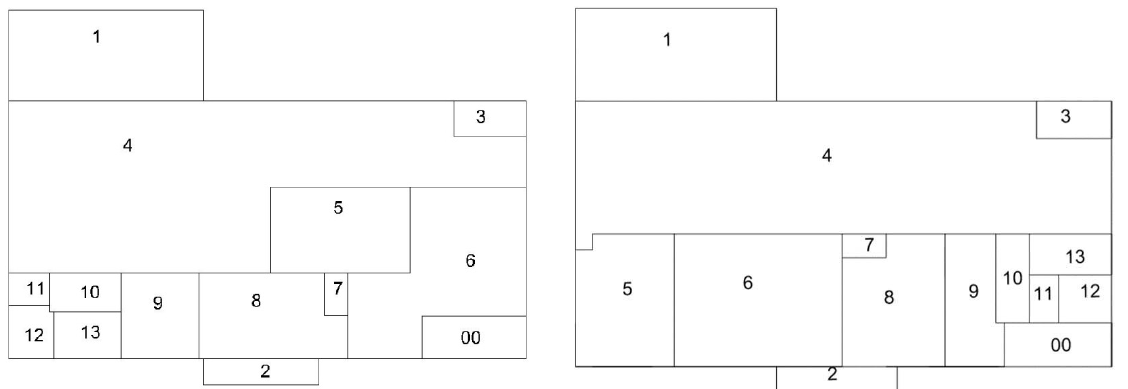
Fig. 6. Layout based on “S” shaped flow pattern Fig. 7. Layout based on “U” shaped flow